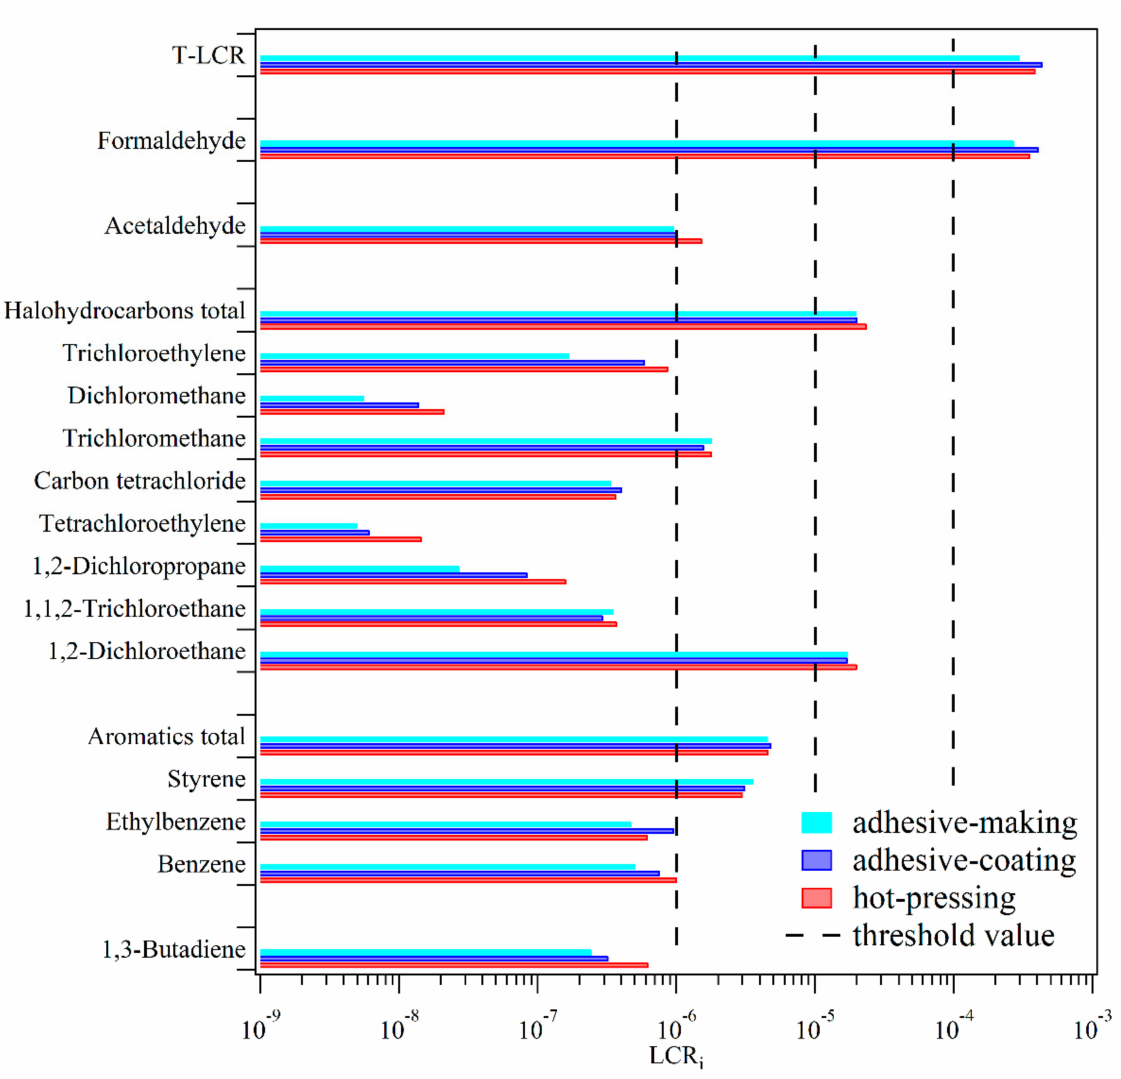
Figure 6. Lifetime cancer risks for individual VOC species (LCR) and total VOCs (T-LCR) from three processes of the plywood manufacturing industry. The dotted lines indicate the threshold